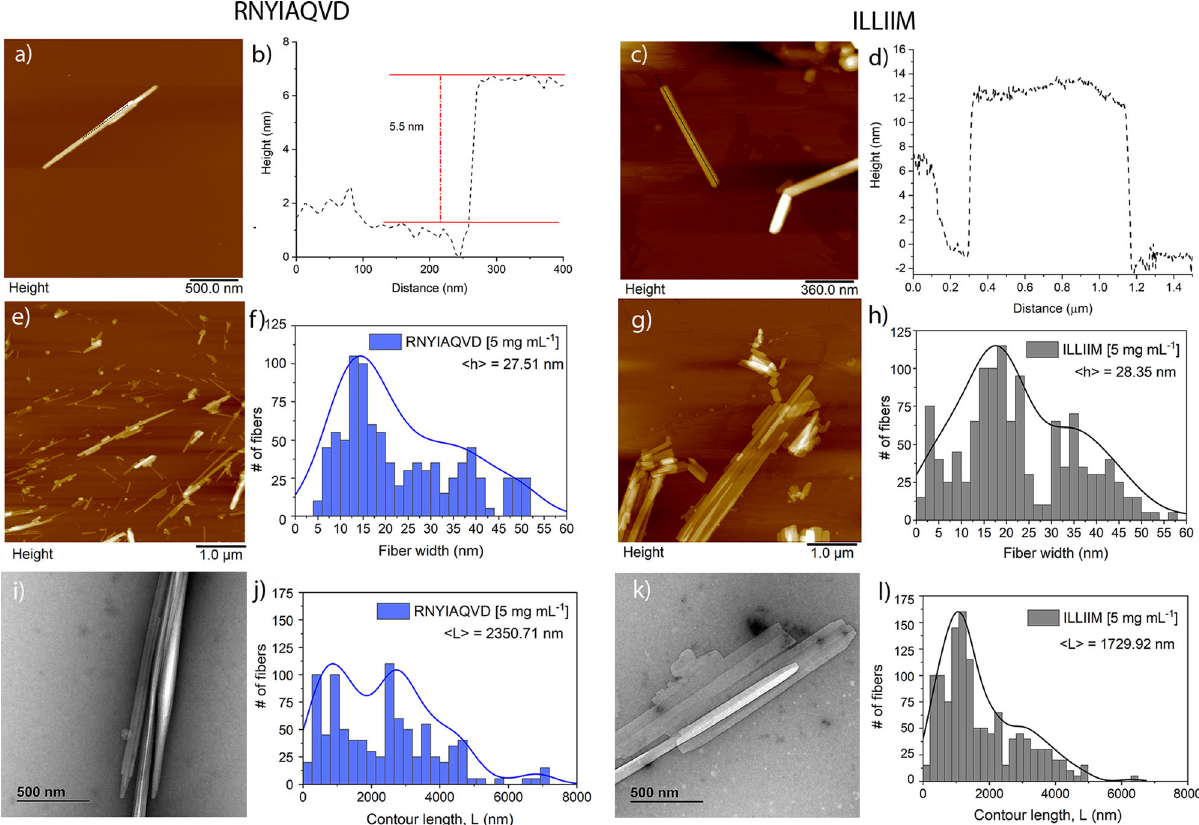
Fig. 2 Atomic force and transmission electron microscopy images of peptide assemblies at 5 mg mL − 1 incubated for 24 h. a – d AFM images and linescans showing variation in assembly width and assembly stacking for both peptides, all AFM images are taken at 512 × 512 scan lines × pixels, at a scanning speed of 0.5 Hz displayed at a z -height of 40 nm using a black – golden – white colour gradient. e – h additional lower magni fi cation AFM images of both assemblies and corresponding fi bre width quantitative analysis. i – l TEM images of the two peptide assemblies, and contour length analysis of the two assemblies (from AFM data). All statistical analysis was performed on datasets including at least 900 assemblies, all histogram fi tting was performed in Origin Pro using the Kernel Smooth fi tting parameters with Scott Bandwith, scaled to 100% of the maximum intensity of the histogram. All images are representative images taken from three independent experiments. Additional examples of TEM and AFM images from other independent experiments can be found in the Supplementary information (Supplementary Figs. 3 –